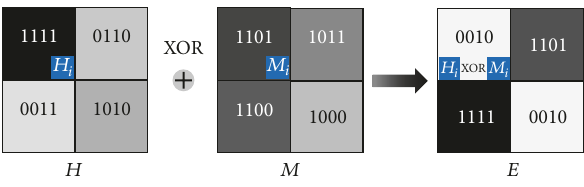
Figure 2: Process of logistic